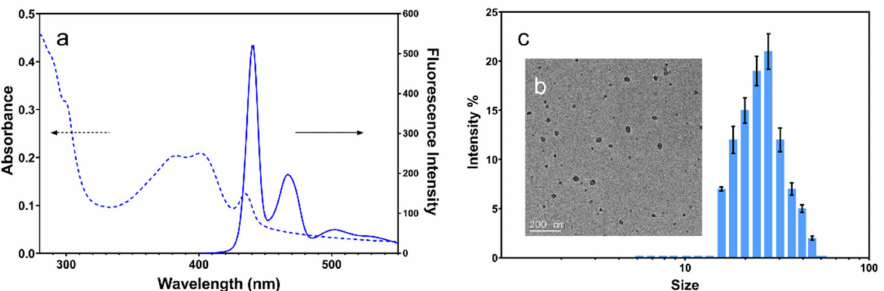
Figure 1. Fluorescence spectra and absorption spectra: ( a ) TEM image ( b ) and particle size distribu- tion diagram ( c ) of